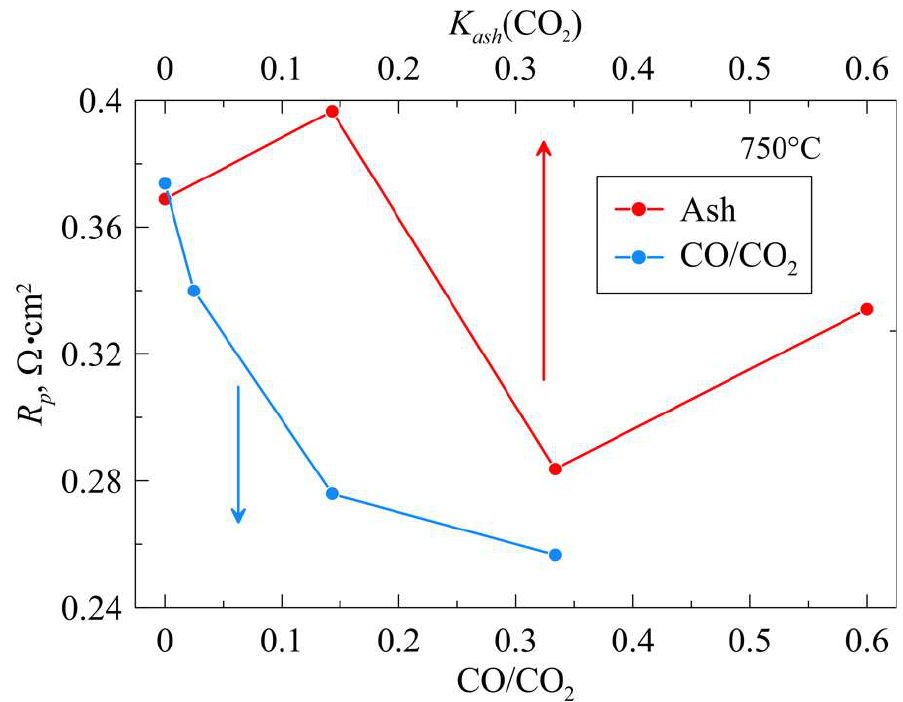
Figure 9. Impact of the presence of the CO vs. solid carbon in fuel on polarization resistance of SOFC. K ash is a ratio of the CO 2 flow through the aerosol generator to the direct CO 2 flow, according to formula K ash = Flow(CO 2,through generator )/Flow(CO 2,direct ).